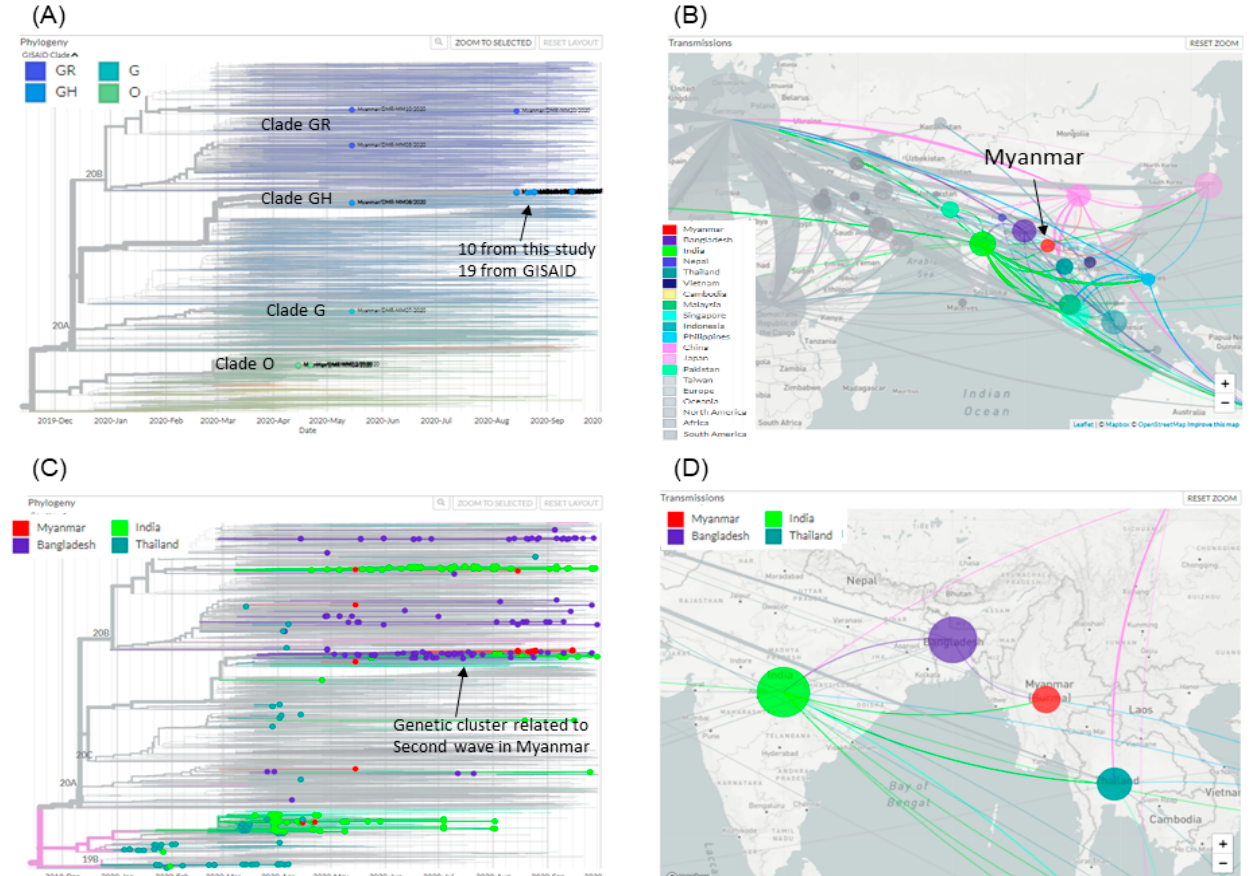
Figure 3. Phylogenetic tree showing the evolutionary relationship of SARS-CoV-2 with 41 Myanmar strains including 10 strains obtained in this study and 6195 global strains collected from December 2019 to September 2020. Sequence data were downloaded from Global Initiative on Sharing All Influenza Data (GISAID), and figures were created by the Nextstrain platform. ( A ) Time-aware phylogenetic tree showing 10 strains from this study (indicated by arrow) and 31 from another study [14], colored by GISAID clade. ( B ) Phylogeographic map showing an estimated geographic relationship among SARS-CoV-2 sequences colored by country. Myanmar was indicated by red. ( C ) Time-aware phylogenetic tree focused on sequences from Myanmar (red), Bangladesh (purple), India (yellow-green), and Thailand (green). The lineage related to local transmission in the second wave in Myanmar in 2020 was indicated by the arrow. ( D ) Phylogeographic map focused on the relationship of the sequences from Myanmar, Bangladesh, India, and Thailand. Of the five amino acid mutations, three major mutations, L37F(G11083T) in the pu- tative transmembrane domain (NSP6) region of the ORF1ab protein, D614G(A23403G) in the S, Q57H(G25563T) in the ORF3a protein, and S194L(C28854T) in the N protein, were observed in all the selected Myanmar strains (100%,10/10). Additionally, S369F (C19145T) in the NSP14 region of the ORF1ab protein was found in three strains (33.3%, 3/10).